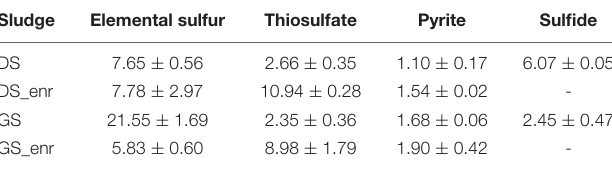
TABLE 3 | Denitrification rates (mM NO 3 − day − 1 ) for the four electron donors with the inocula (DS and GS) and the enriched cultures in the last transfer (DS_enr and